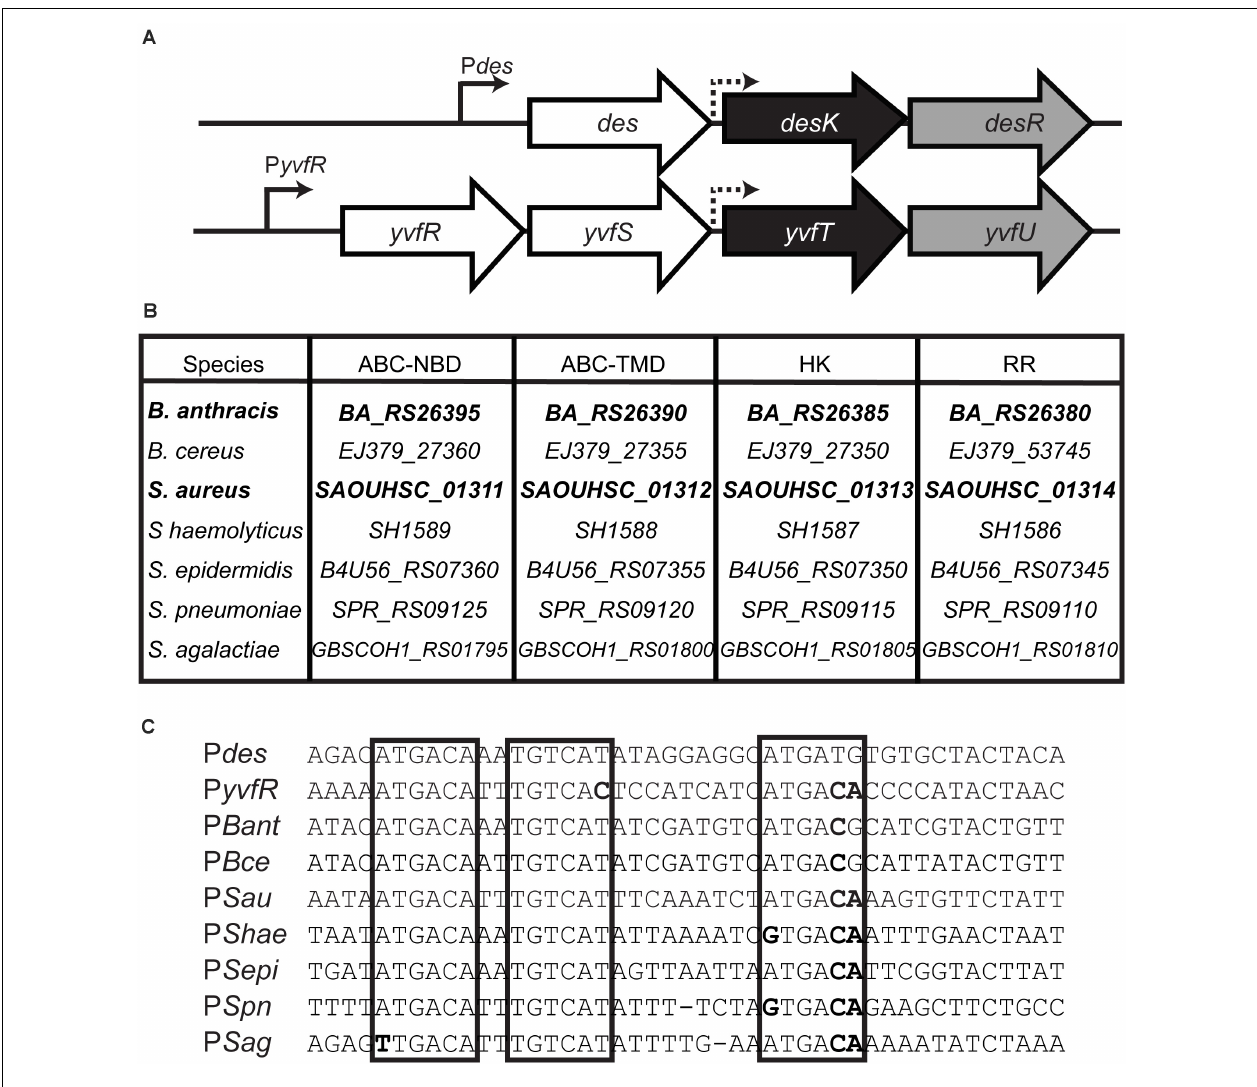
FIGURE 2 | (A) Chromosomal organization of the B. subtilis homologous TCS regions. Sensor HK genes are shaded in black, RR in gray and upstream genes in white. des : desaturase; yvfR ABC transporter nucleotide binding domain (ABC-NBD), yvfS ABC transporter TM domain (ABC-TMD). Continuous arrows represent promoters and dashed arrows putative promoters. (B) Conserved clusters among Gram positive pathogens. The gene names of different species were extracted from GeneBank. B. anthracis str. Ames, B. cereus ATCC 14579, Staphylococcus aureus RN4220, S. haemolyticus JCSC1435, S. epidermidis 1457, Streptococcus pneumonia R6, S. agalactiae COH1. (C) Alignment of promoter regions. Direct and inverted repeats involved in RR binding in P des promoter (Najle et al., 2009) are marked in boxes. Sequence differences respect to P des are shown in